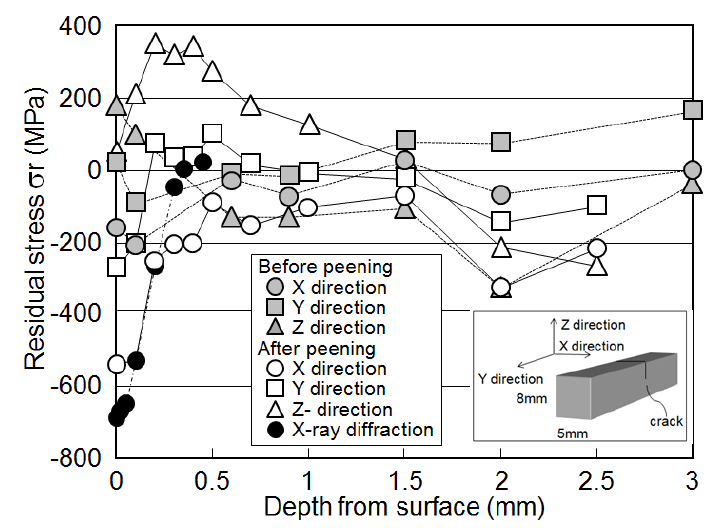
Figure 13. Residual stress distributions in near-surface of water jet peened type 304 stainless steel bar with simulated stress corrosion cracking considering the pseud peak shift.